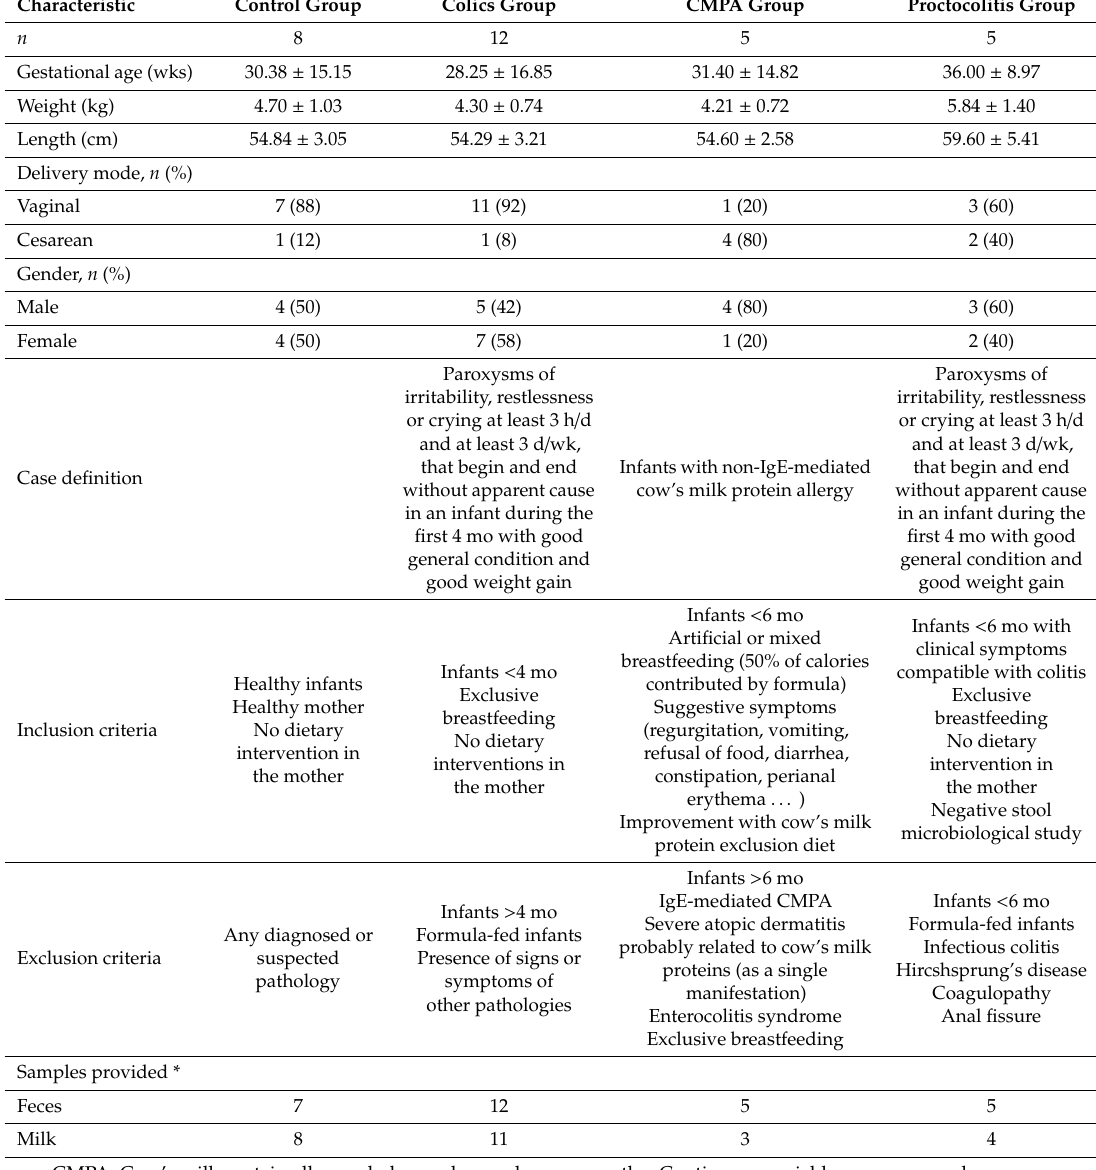
Table 1. Demographic and clinical characteristics of the four groups of participating infants ( N = 30), including case definition and inclusion and exclusion